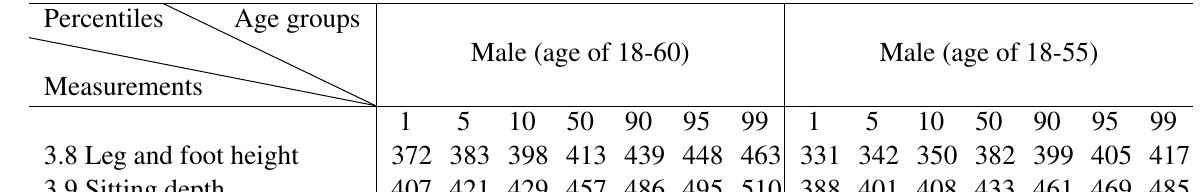
Table 1 Sitting body dimension(part). (unit: mm)